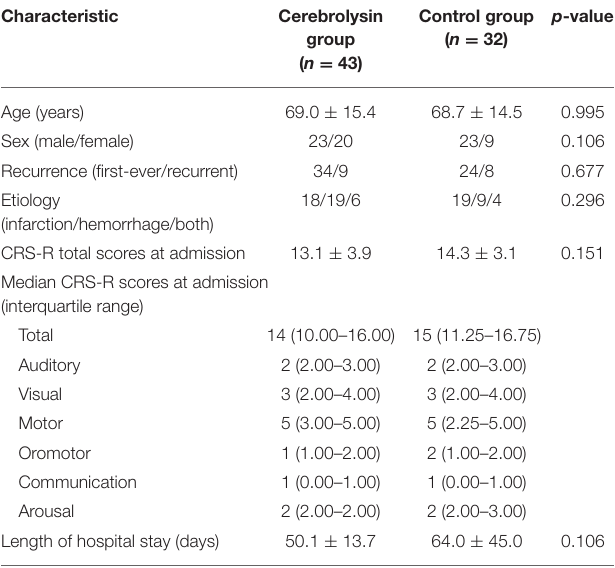
TABLE 1 | Baseline characteristics of subjects.